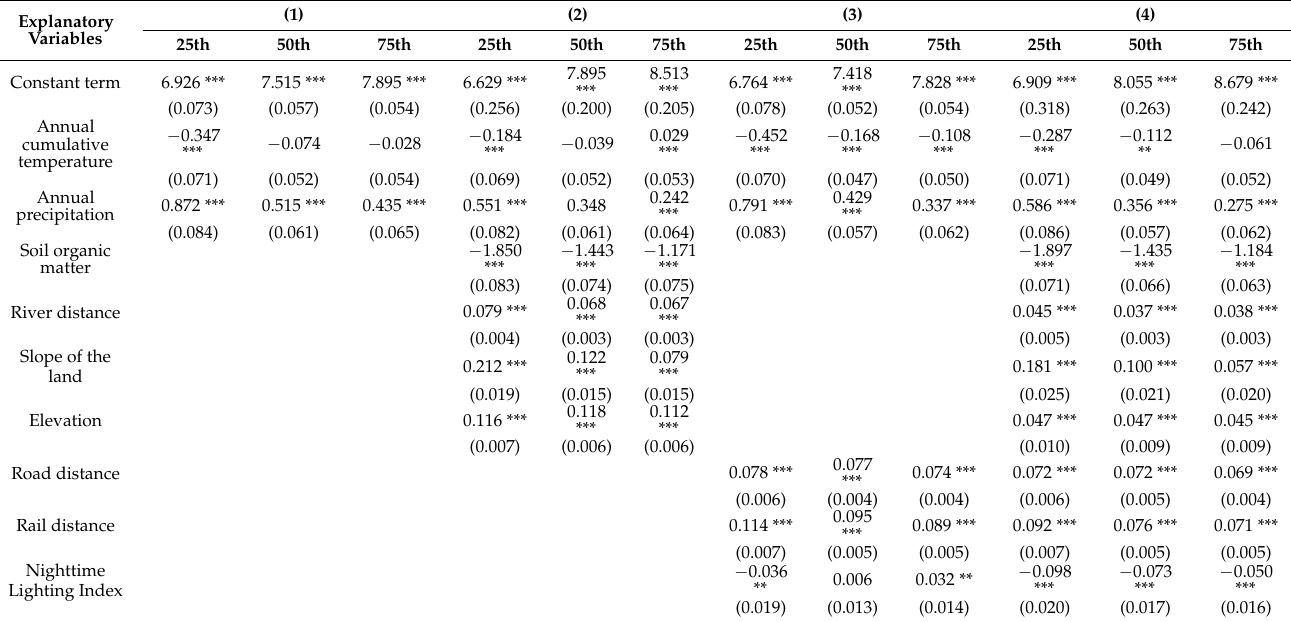
Table 3. Panel quantile regression results of rice